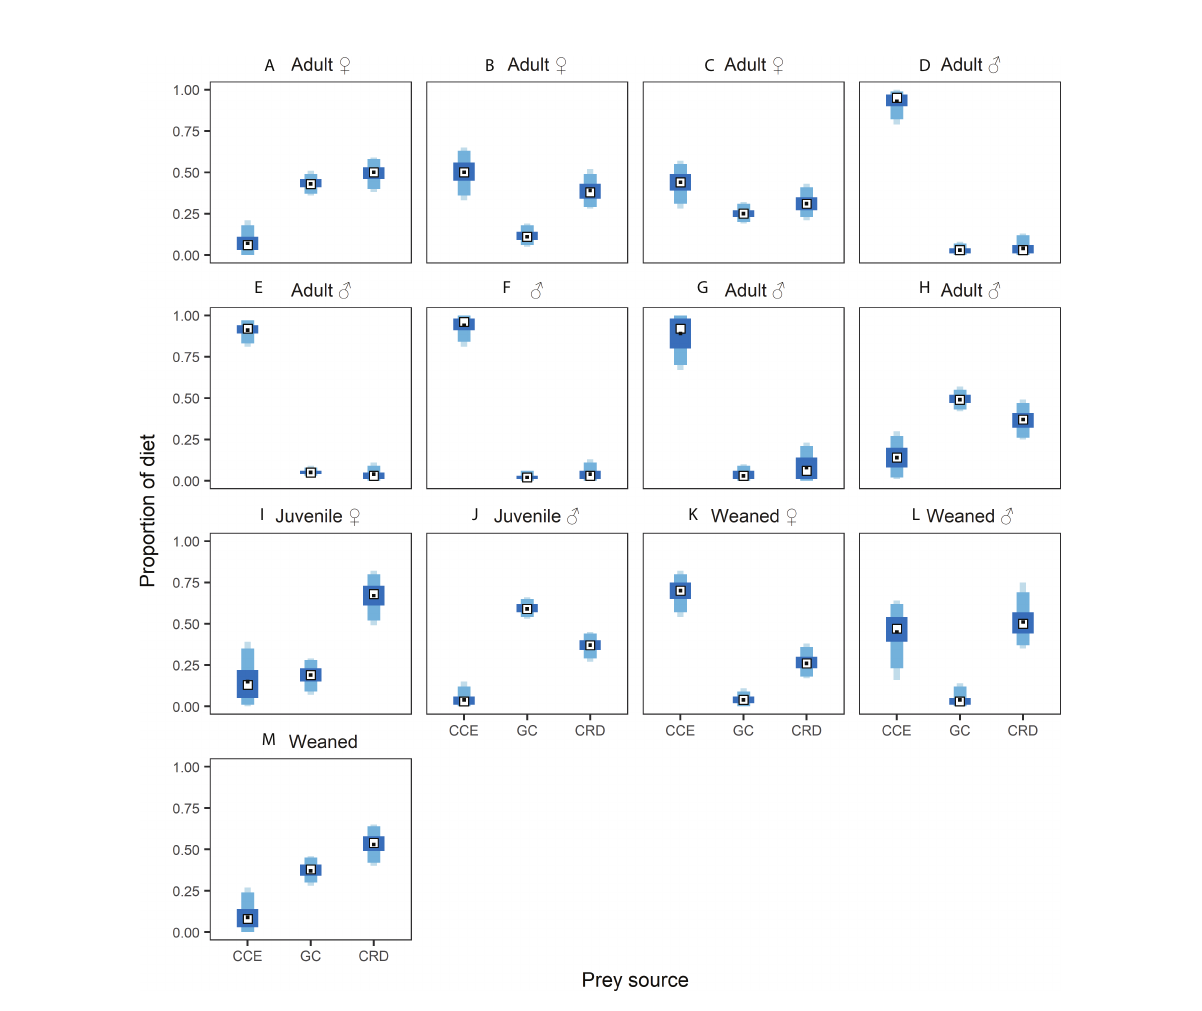
FIGURE 8 Standardized posterior probabilities of the relative contribution of prey sources from the California Current Ecosystem (CCE), Gulf of California (GC), and Costa Rica Dome (CRD) to blue whales in the northeast Paci fi c Ocean. Each plot shows the mean (black dot), median (white square) and shaded boxes represent the 50%, 75% and 95% and 95% credible intervals from dark to light blue. Figure shows whales